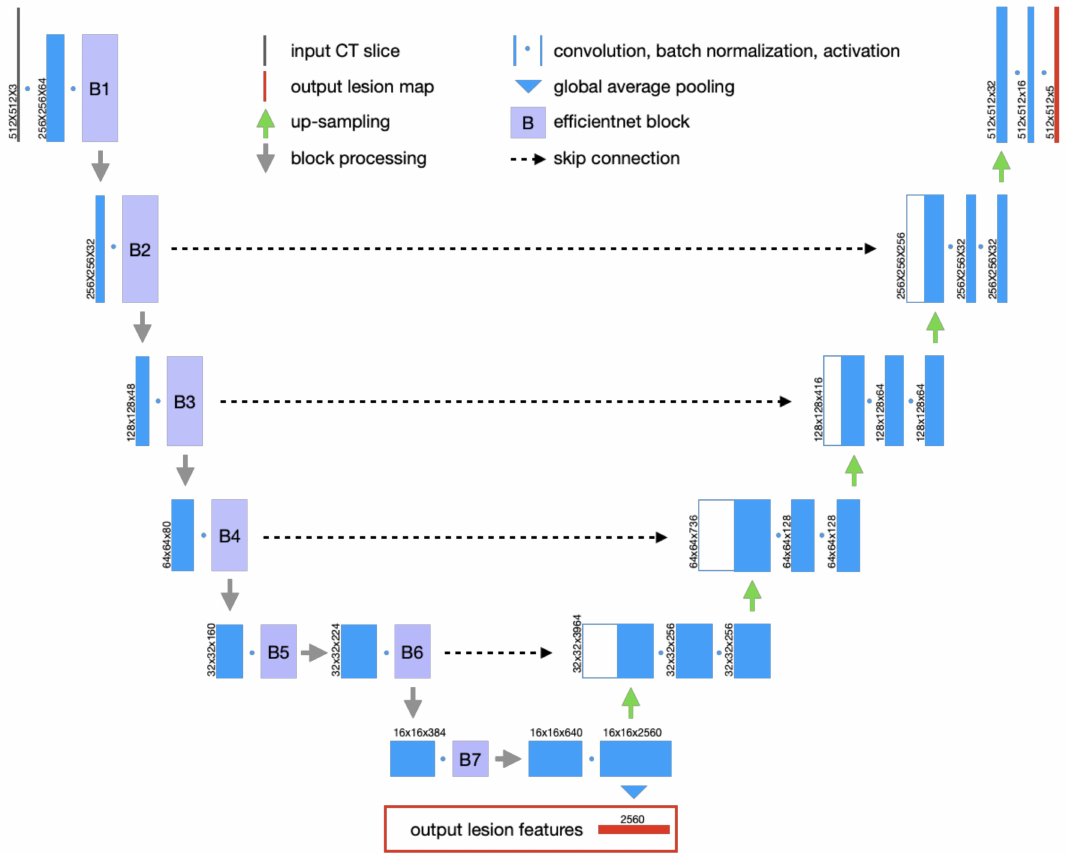
Figure 3. The U-Net architecture for lesion detection and feature